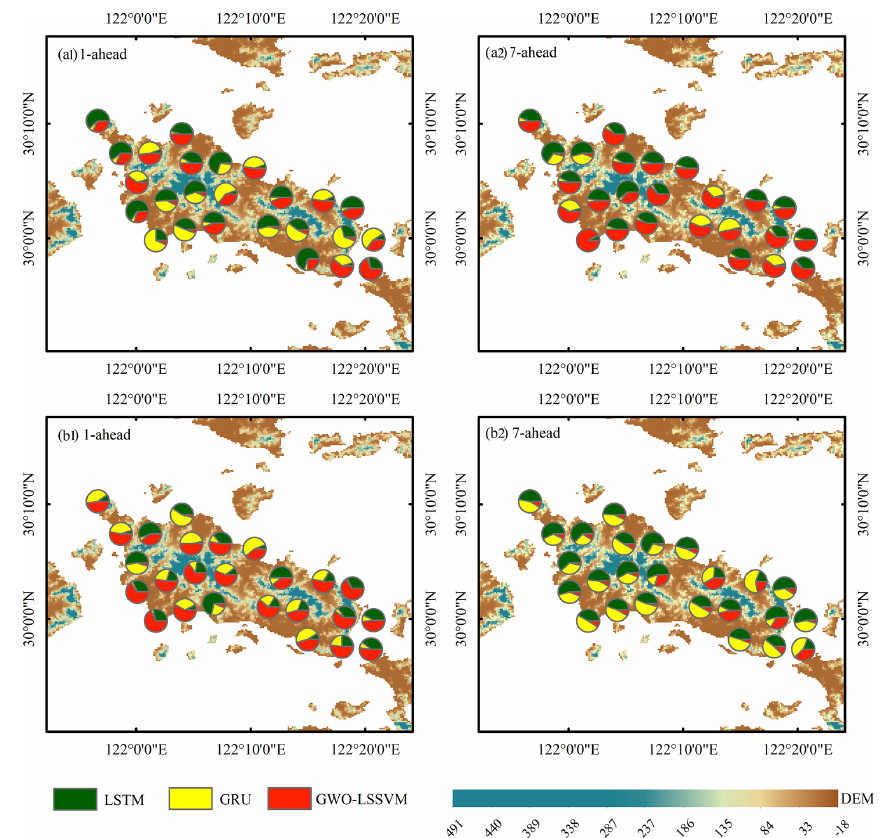
Figure 8. Weights of three individual forecast models for the BMA model for all reservoirs under (a) S3 and (b)